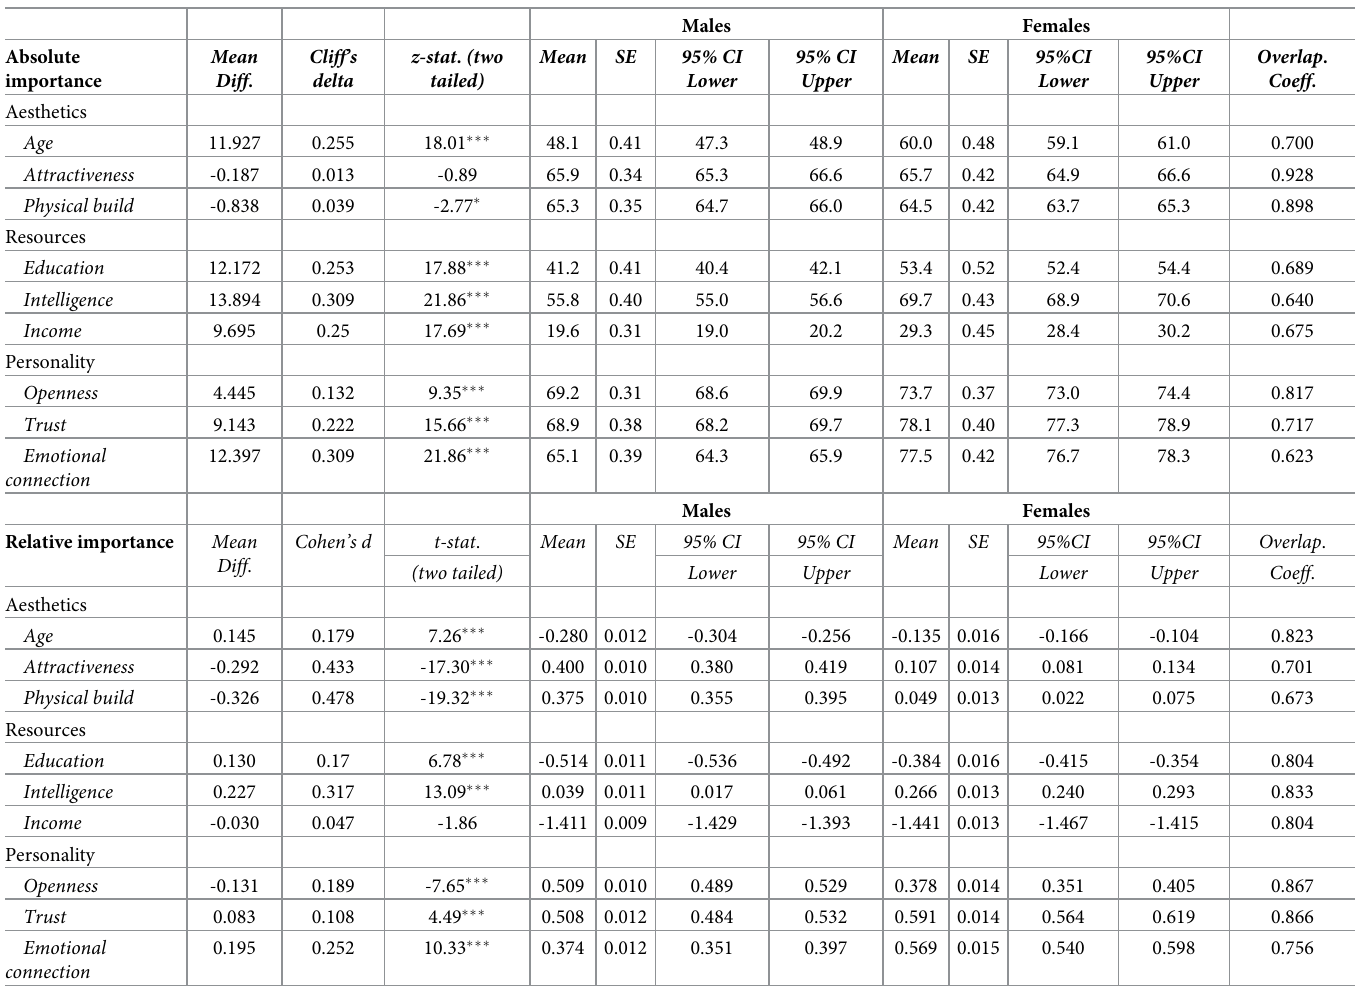
Table 1. Sex preference differences in